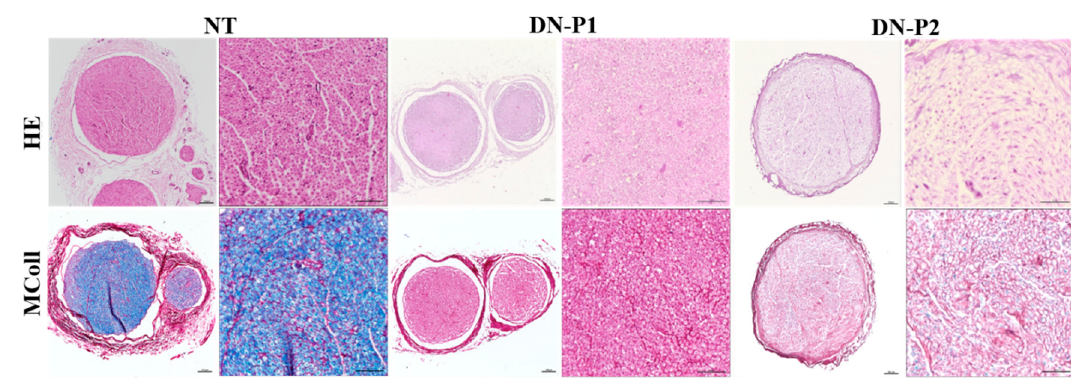
Figure 1. Representative panel of native and decellularized rat sciatic nerves reporting the morphological architecture. Sections stained with hematoxylin and eosin (HE) identify the overall nerve histoarchitecture. MCOLL staining shows myelin (blue) and collagen (red) simultaneously. Scale bar = 100 µ m for lower magnification images and 50 µ m for higher magnification